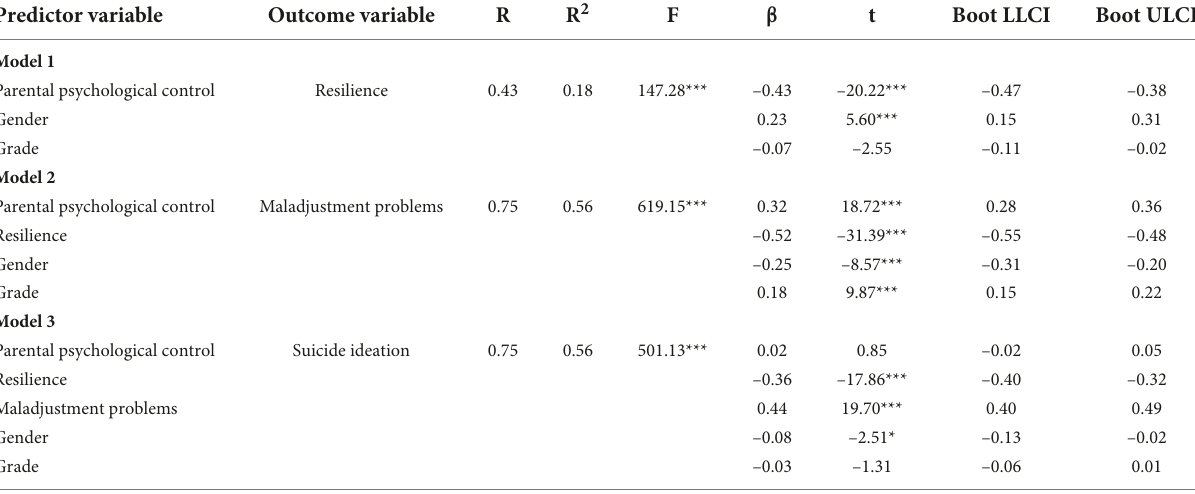
TABLE 3 The chained mediation models of resilience and maladjustment problems (MP) in the relationship between parental psychological control (PPC) and suicide ideation (SI) after controlling for the effects of gender and grade ( n = 1971). Predictor variable